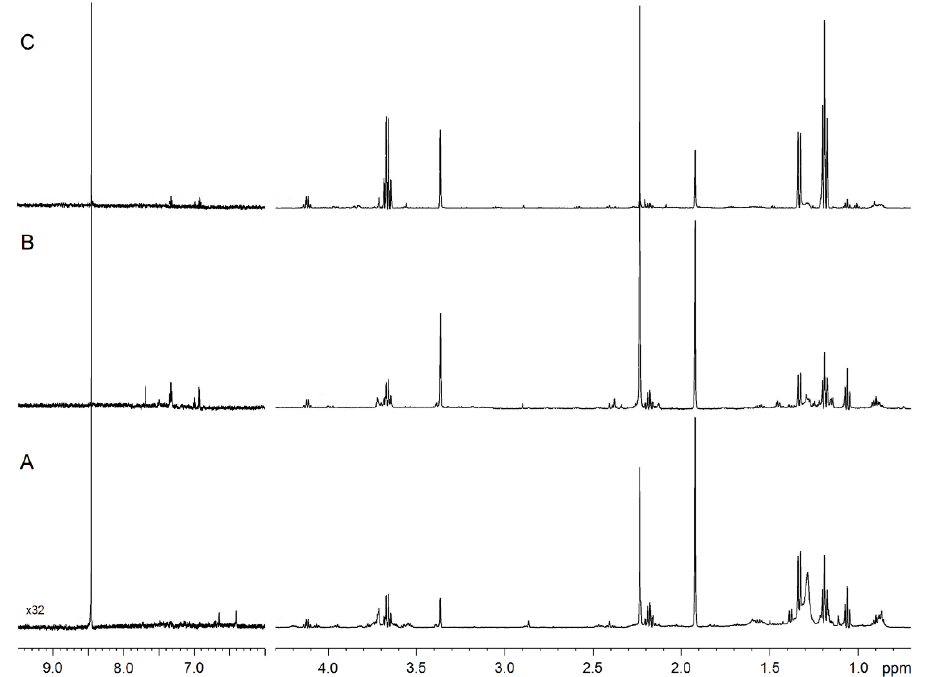
Figure 1. NMR spectra of exhaled breath condensate (EBC) samples. Representative 1D 1 H spectra of a healthy subject ( A ), a non-cystic fibrosis (nCF)/non-primary ciliary dyskinesia (nPCD) bronchiectasis ( B ), and a PCD bronchiectasis ( C ). Signals were assigned to single metabolites by resorting to 2D NMR experiments and referring to published data on metabolite chemical shifts.